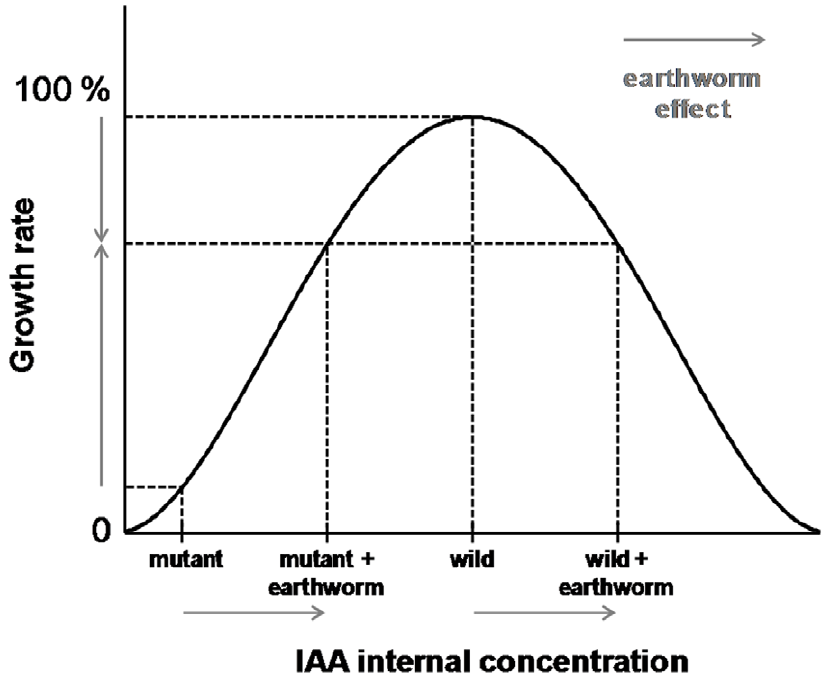
Figure 6. Model explaining contrasting effects of the earthworm Aporrectodeacaliginosa on Arabidopsisthaliana . This model explains positive as well as negative effects on Arabidopsis thaliana wild type and mutant for auxin transport ( aux1-7 axr4-2 ). Note that the effect of an exogenous auxin supply in the presence of earthworms is dependent on the initial auxin concentration in root cells.